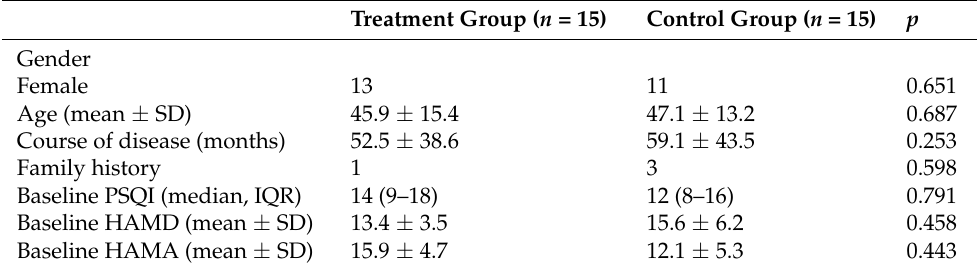
Table 1. Comparisons between treatment and control groups, at baseline.